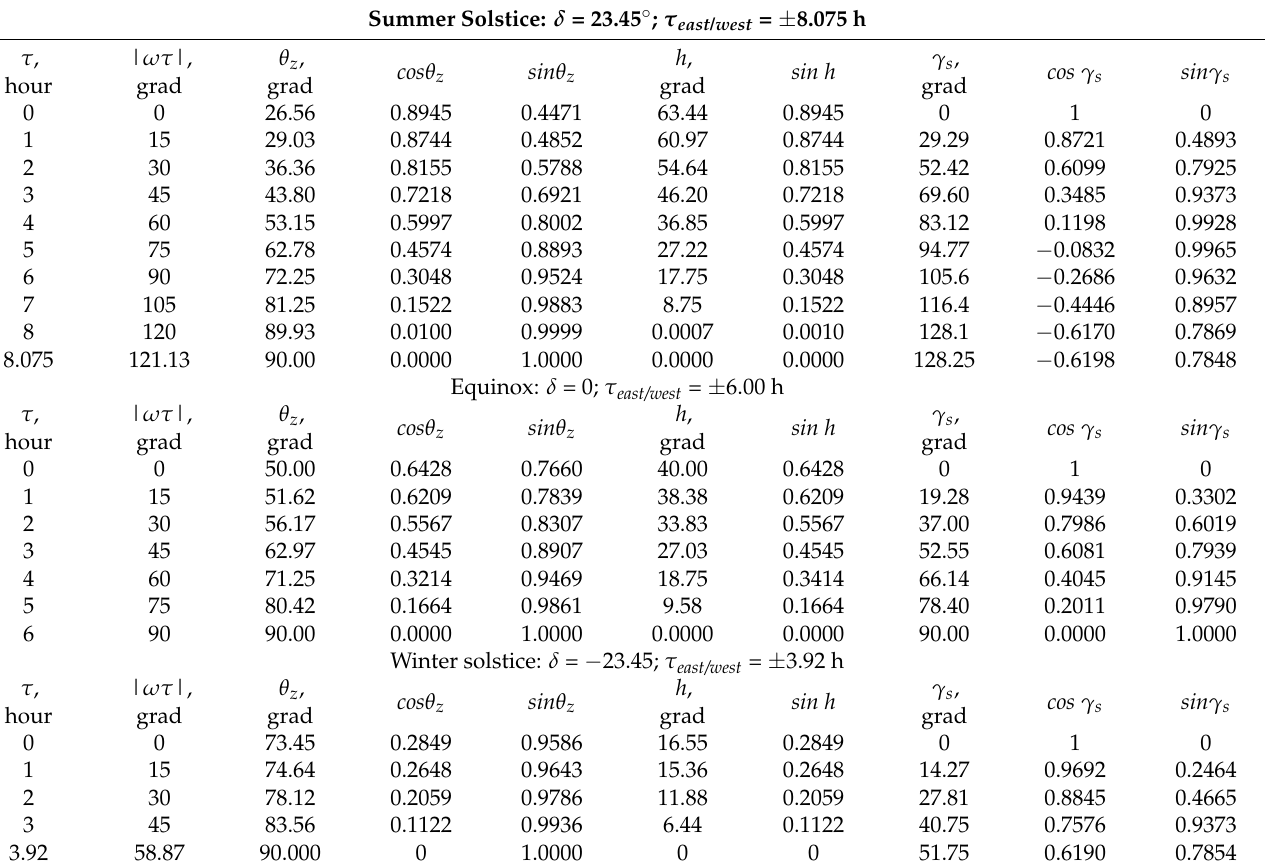
Table 2. Angular dimensions of a direct flux of solar energy for the latitude ϕ = 50 ◦ ; (own research).